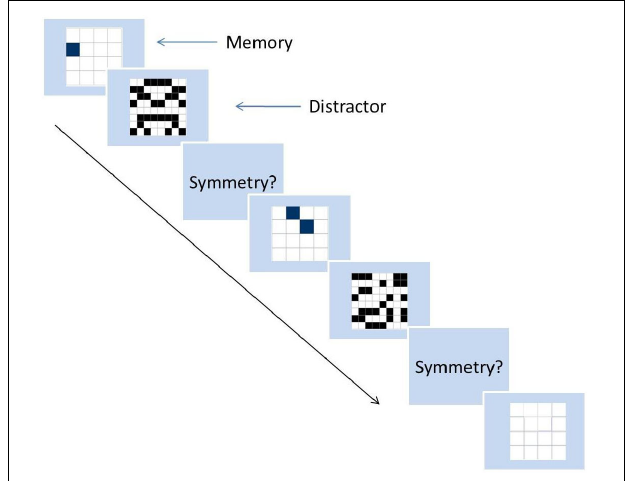
FIGURE 2 | Sample process of symmetry span task